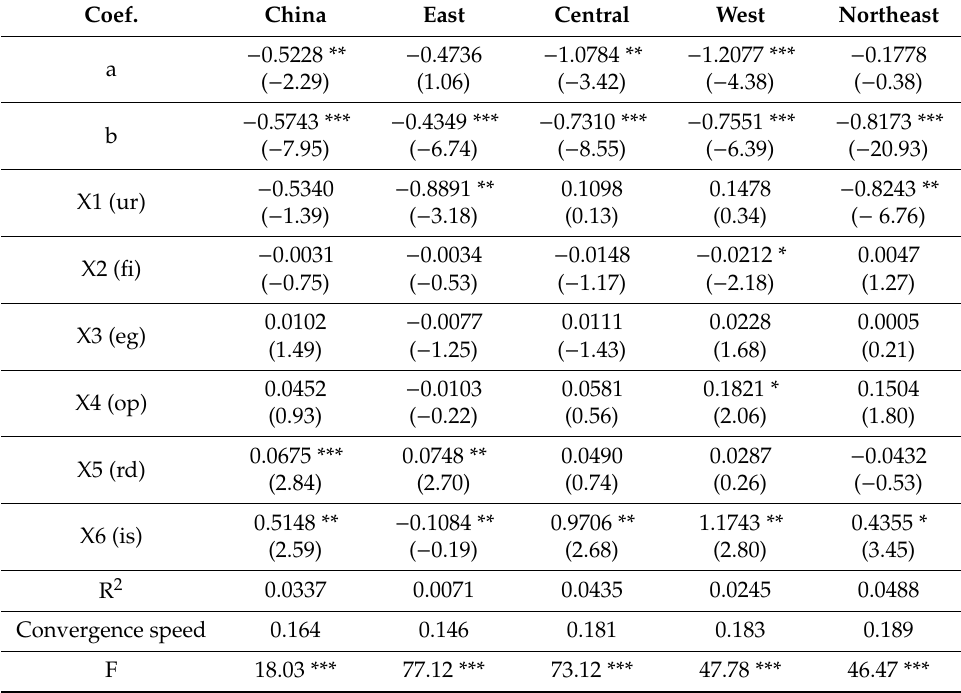
Table 6. Estimation results of spatial econometric model of test for beta convergence. Coef. China East Central West Northeast − 0.5228 ** a